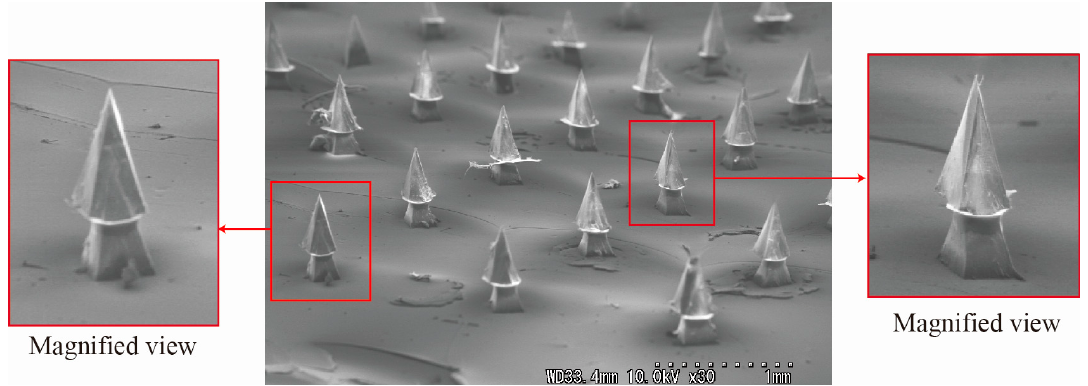
Figure 6. Produced arrayed tip-separable microneedle